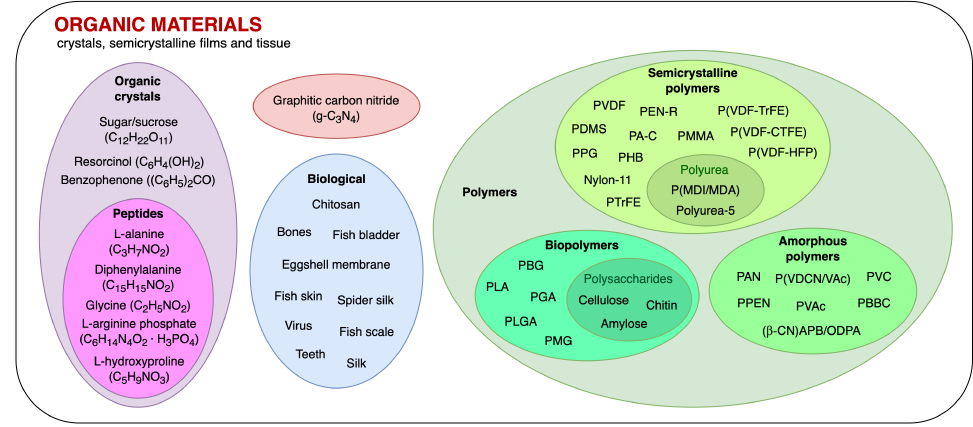
Figure A5. The class of organic materials consisting in organic crystals, biological materials and